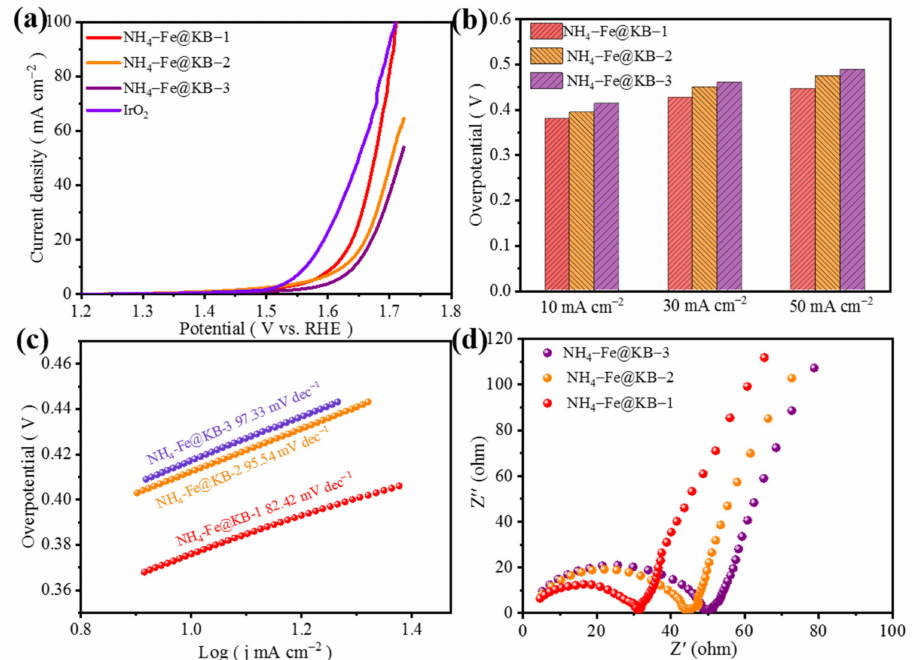
Figure 6. ( a ) NH 4 -Fe 3 @KB-1, NH 4 -Fe 3 @KB-2, NH 4 -Fe 3 @KB-3 and IrO 2 polarization curves; ( b ) NH 4 - Fe 3 @KB-1, NH 4 -Fe 3 @KB-2, NH 4 -Fe 3 @KB-3 at overpotentials reaching current densities of 10, 50, and 100 mA cm − 2 ; ( c , d ) the Tafel slope and EIS diagram of NH 4 -Fe 3 @KB-1, NH 4 -Fe 3 @KB-2, NH 4 -Fe 3